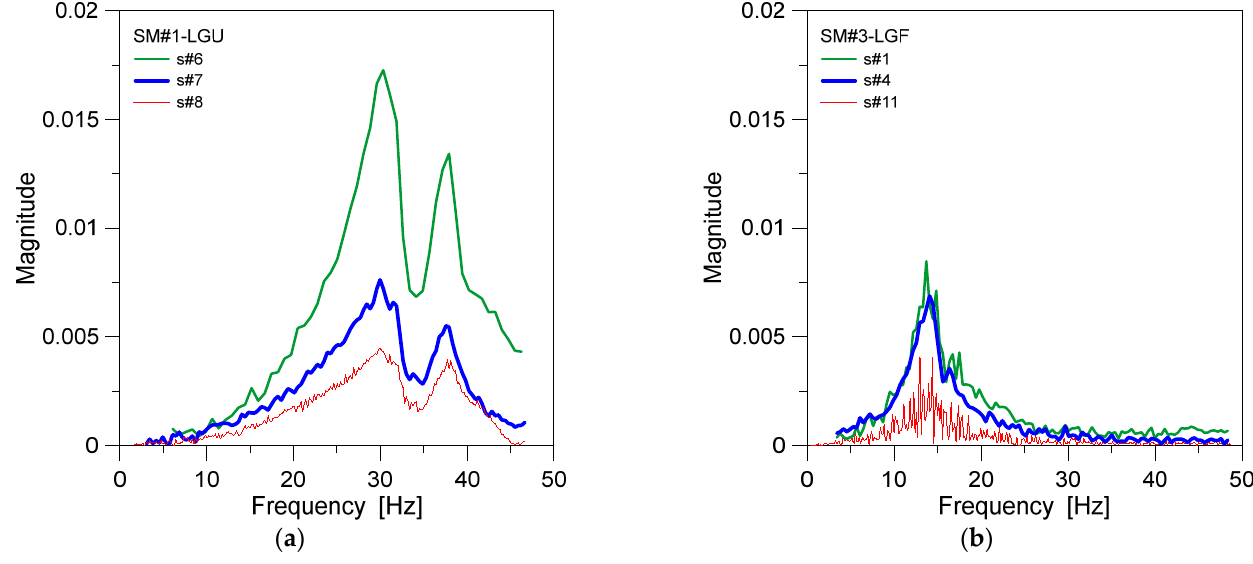
Figure 10. Frequency domain response of the examined systems: example of selected experimental signals for the ( a ) SM#1–LGU and ( b ) SM#3–LGF modules.